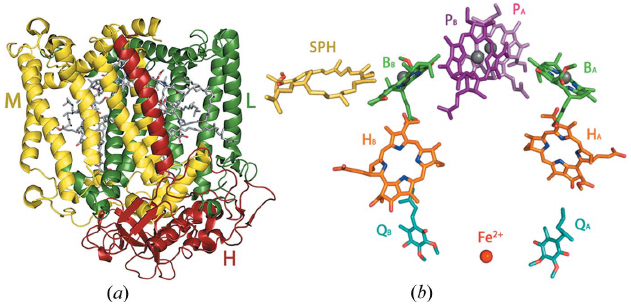
Figure 1 ( a ) Structure of the Rba. sphaeroides RC (PDB entry 3v3y). The L, M and H subunits are shown in green, yellow and red, respectively; ( b ) RC cofactors organized in two electron-transfer chains. P A and P B , bacterio- chlorophyll dimer; B A and B B , bacteriochlorophyll monomers; H A and H